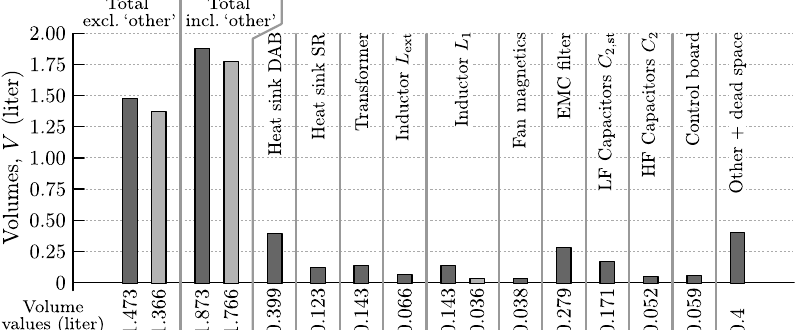
Figure 23. Volume contribution of the different converter components for both converter designs A (prototype; dark gray bars) and B (optimized; light gray